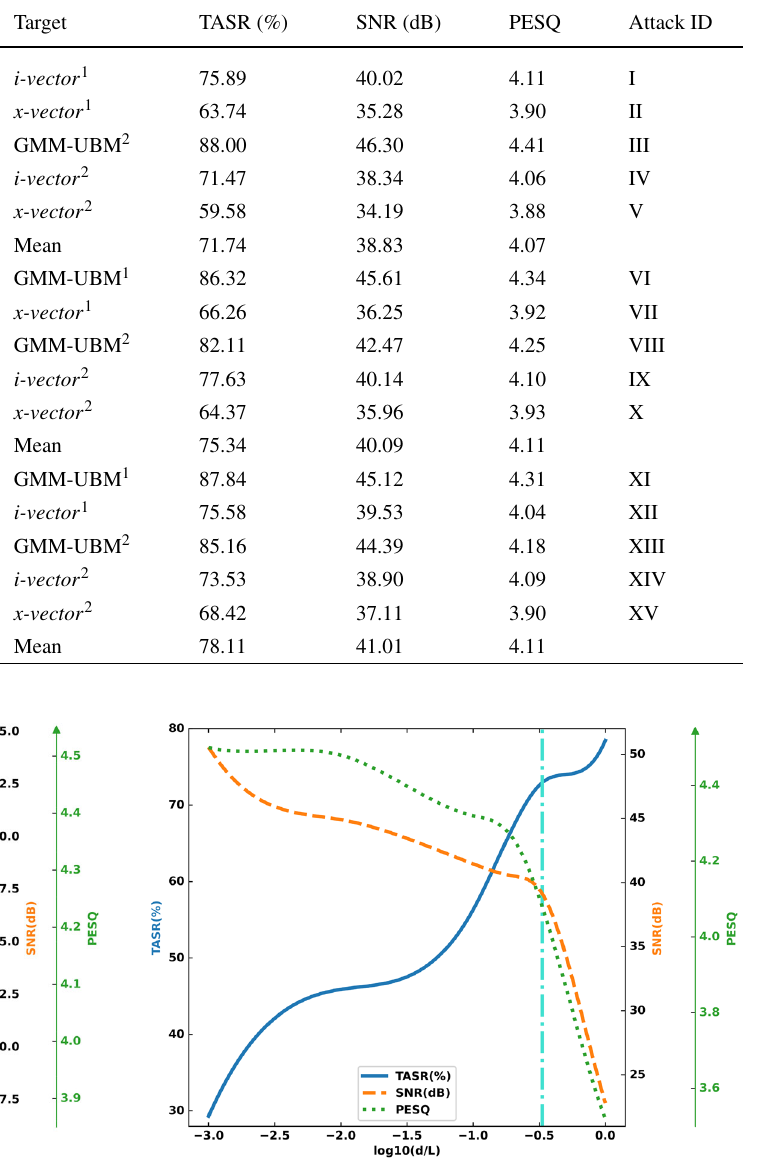
Fig. 6 Parametersensitivitywithrespectto d onCSIwith x-vector asthe speaker recognition model. The vertical line indicates the performance with d (cid:2) L/ 3. λ and ζ are fixed to 0.005 and 0.003, respectively